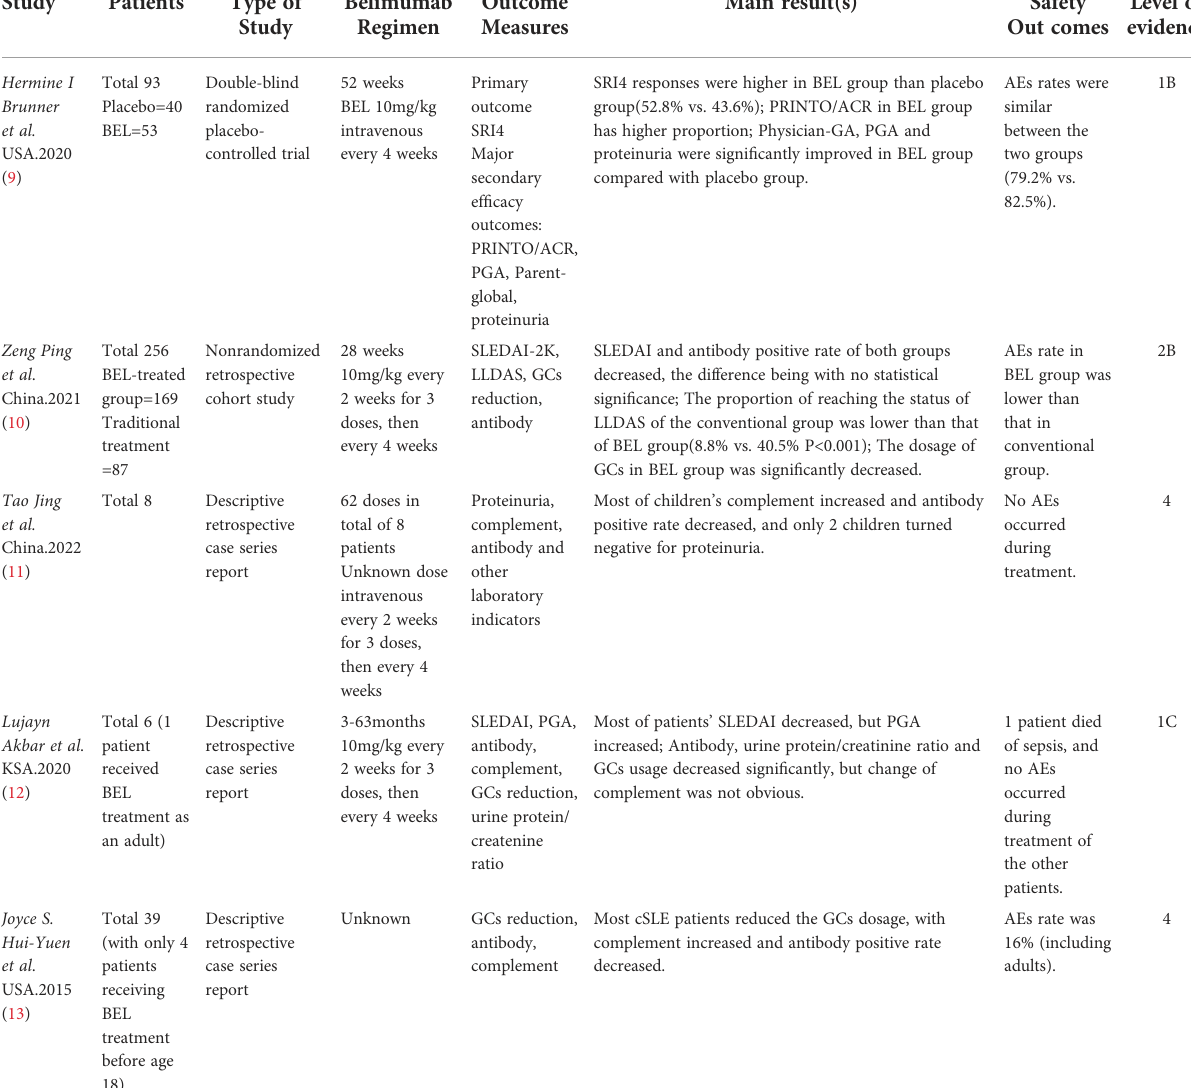
TABLE 1 summarizes the fi ve publications relating to the treatment of cSLE with